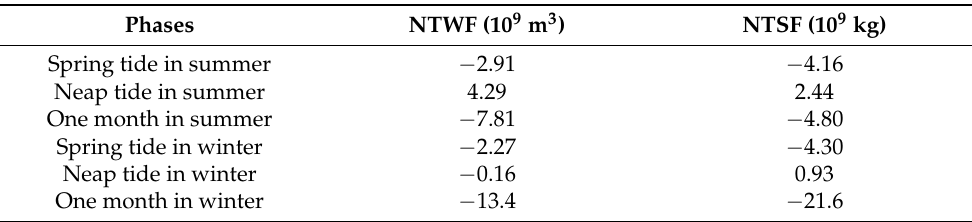
Table 3. NTWF and NTSF across the section from Nanhui Cape to the Qiqu Archipelago. Negative val- ues indicate flow into Hangzhou Bay, and positive values indicate flow into the Changjiang